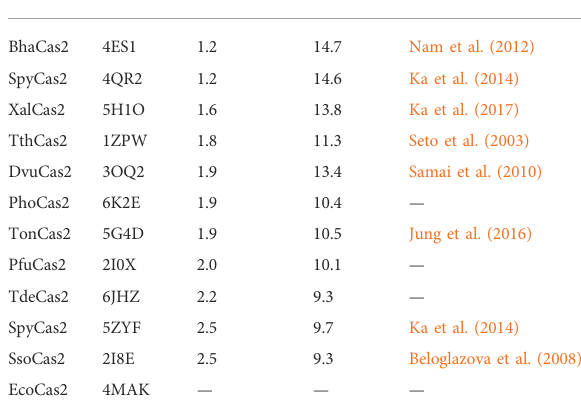
TABLE 2 List of structural homologs of LinCas2C.